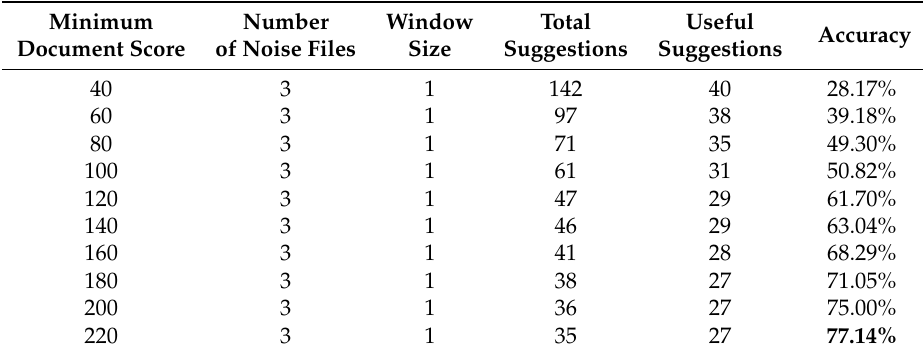
Table 6. Hybrid approach – minimum document score